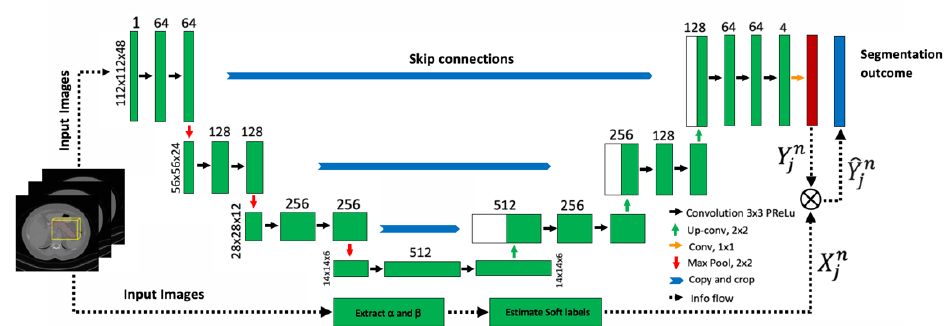
Figure 2. The architectural diagram of the proposed methodology. The probability map for segmen- tation Y n obtained from the U-Net is updated to ˆ Y n j obtained through Bayes probability using α and β .